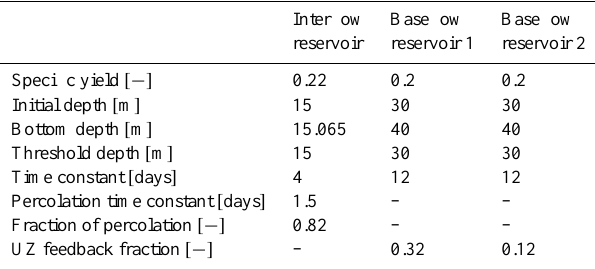
Table 4. MIKE SHE calibrated parameters for the saturated zone. Table 5. MIKE SHE calibrated parameters for the surface.